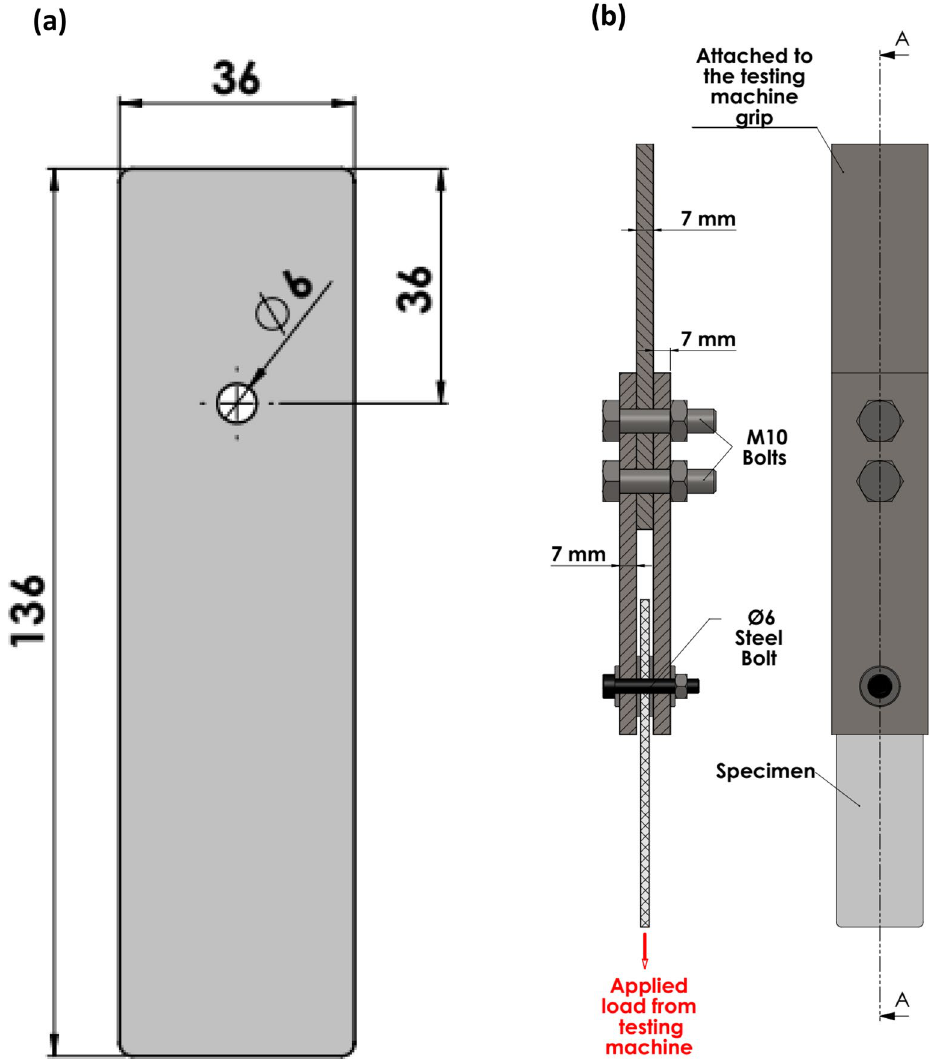
Figure 3. Bearing test; ( a ) specimen and ( b ) fixture.